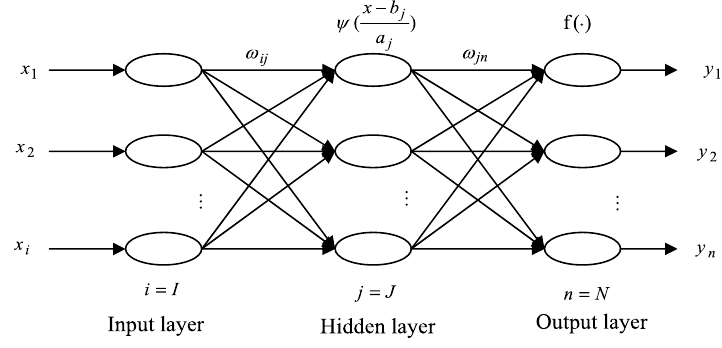
Fig. 2. The three-layer architecture of the wavelet neural